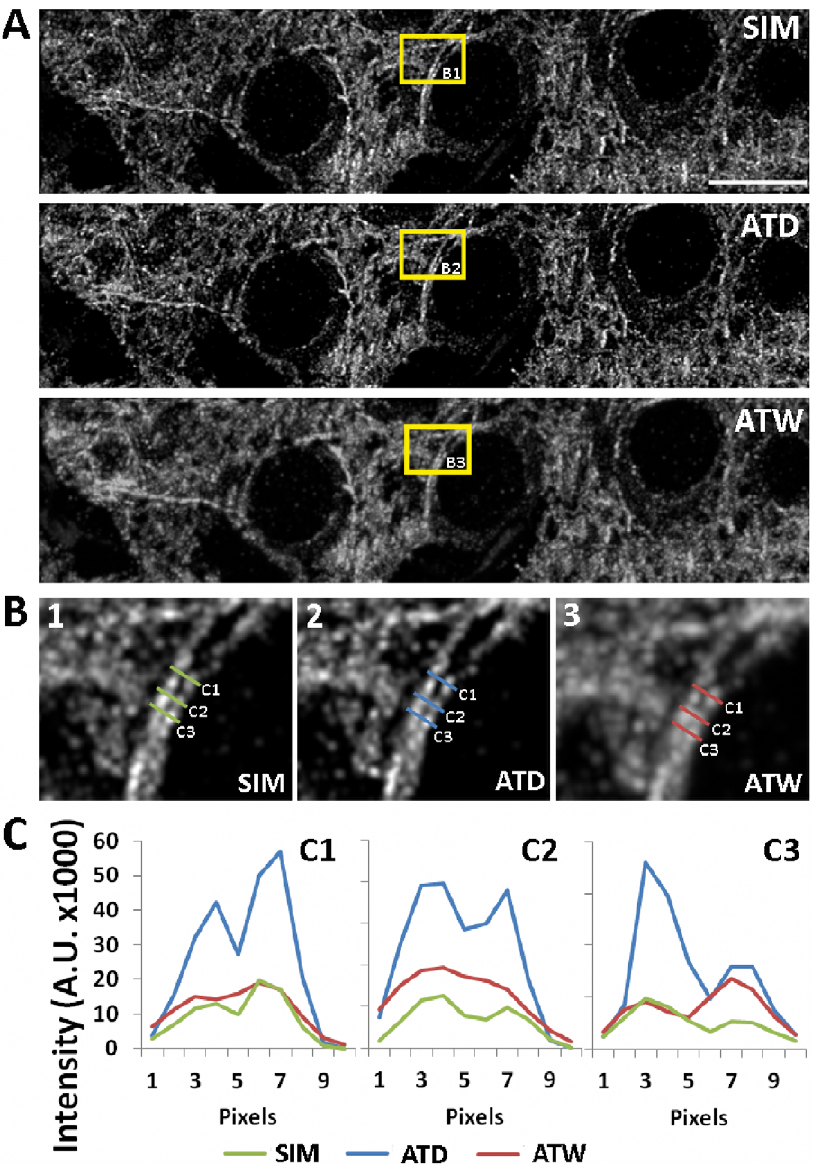
Figure 5. Comparison of microtubules imaged using SIM versus deconvolution. (A) Max projection of identical tissue volumes (ten 70 nm sections) imaged in SIM, ATW and ATD. Scale Bar=10 um. (B–C) We quantify two parallel microtubules at the cross sections marked in the blow-up images in (B). Intensity cross sections (C) along the length of the microtubules show that the peaks of the microtubules are clearly resolved in the deconvolved and SIM scenario, whereas the peaks in the wide-field images are barely separated. The intensity of deconvolved image is higher, because it represents the computationally returned light at that pixel from the more blurred original image. For a more quantitative measurement of the similarity between SIM, ATD and ATW images, the Pearson’s correlation coefficient is calculated using the images, which is: SIM to ATW=0.8394. SIM to ATD=0.8862, and ATW to ATD=0.8982. The numbers confirm that in reference to the SIM, ATD is a closer match than ATW. cut-off of the objective. The MTF of the actual AT images are